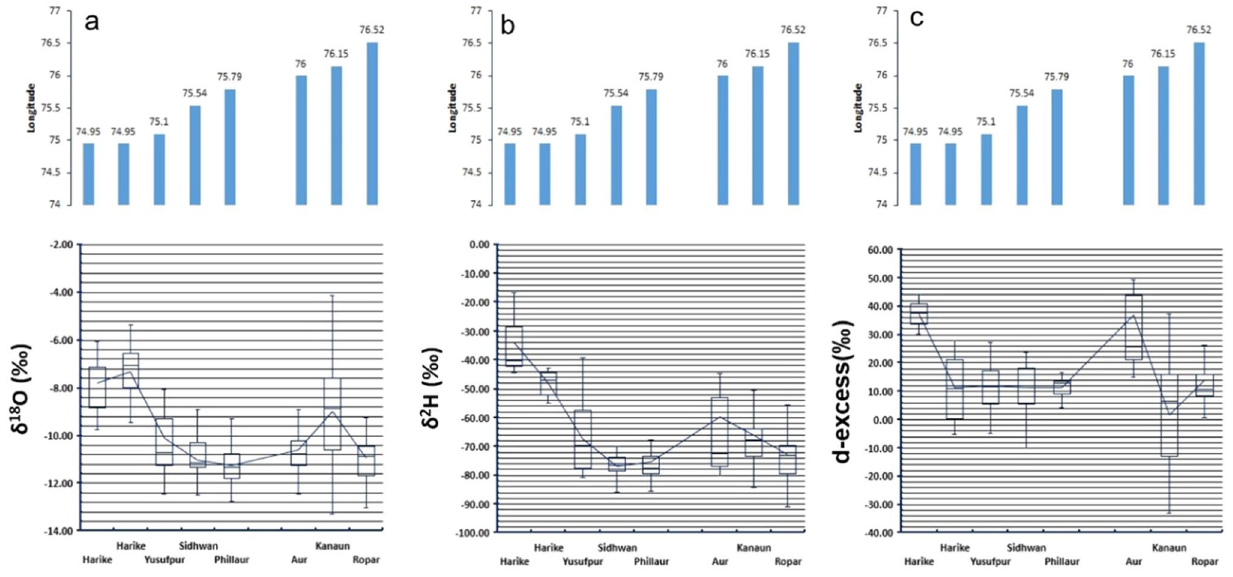
Fig. 7 The box and whisker plot diagram of δ 18 O (a), δ 2 H (b), and d-excess (c) for Sutlej